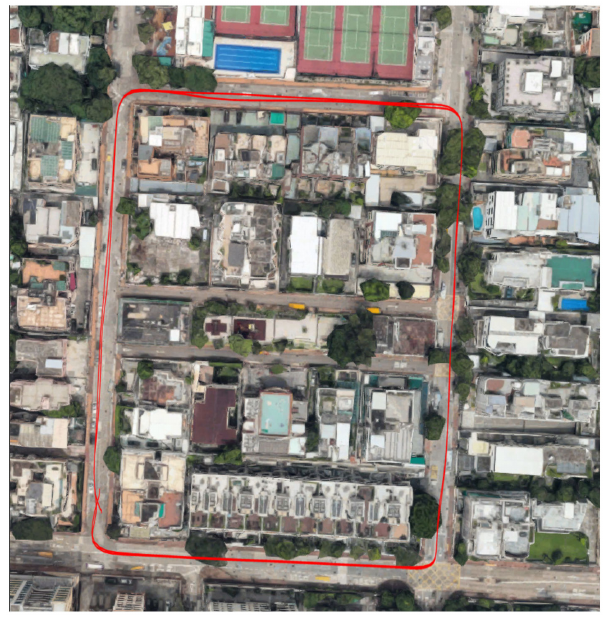
Figure 11. The path of the vehicle platform in an urban environment.